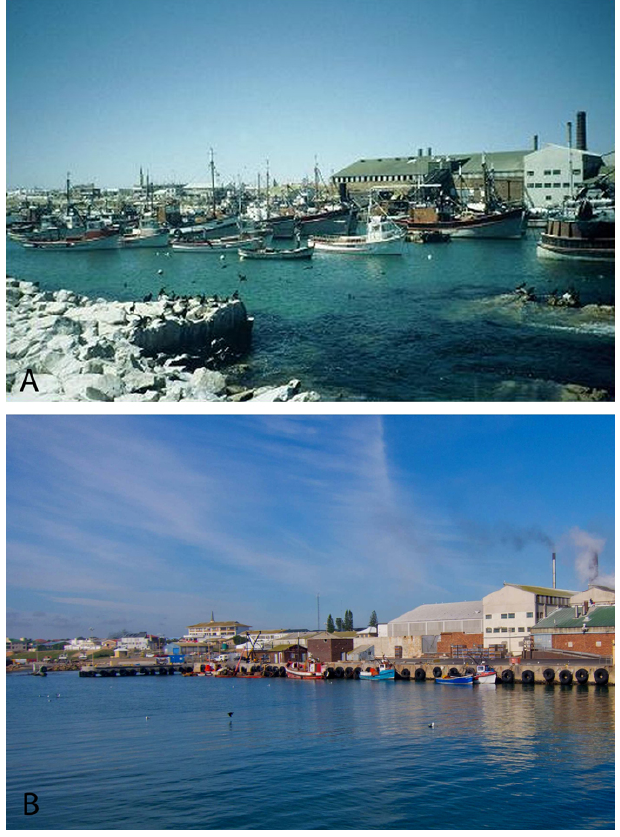
Fig. 3 . Lambert’s Bay harbor A. Active purse seiner fleet in the 1990s (from http://trawlerheritage.co.za/Fishing% 20Harbours%20and%20Factories/Lambertsbaai/Lamberts% 20Bay.htm). B. 2012, remaining small boats after conversion of the cannery to potato